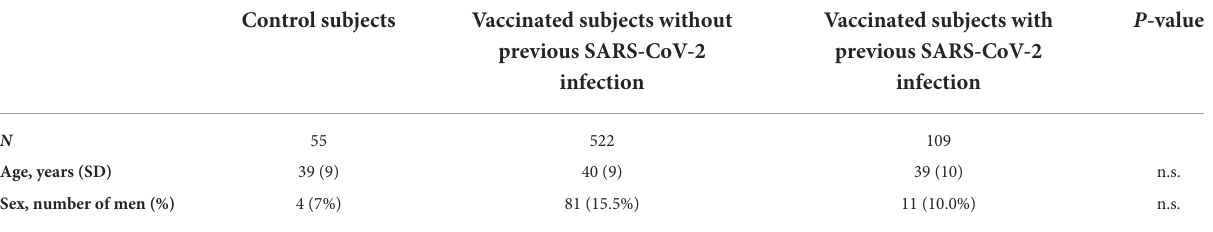
TABLE 1 General characteristics of controls subjects and subjects vaccinated with ChAdOx1-S.